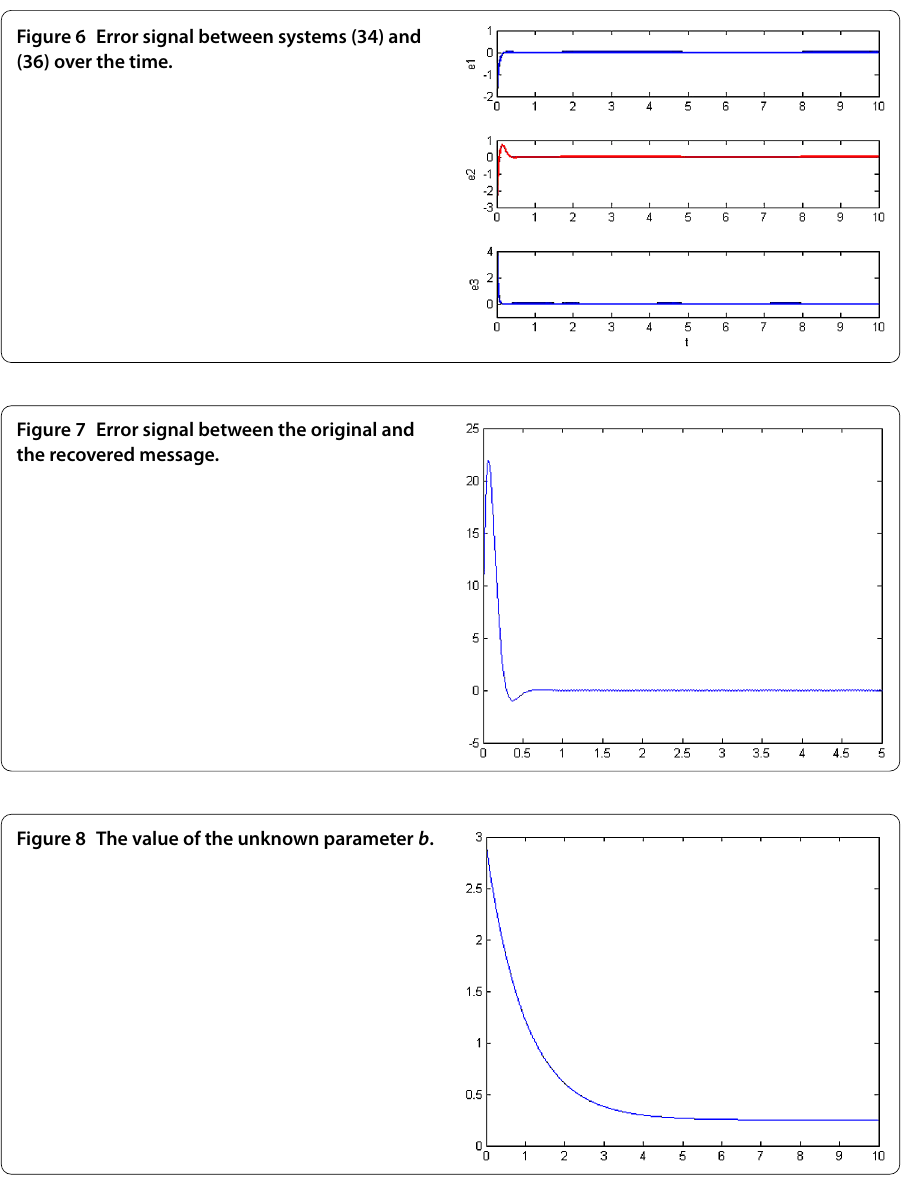
Figure 6 Error signal between systems (34) and (36) over the time.